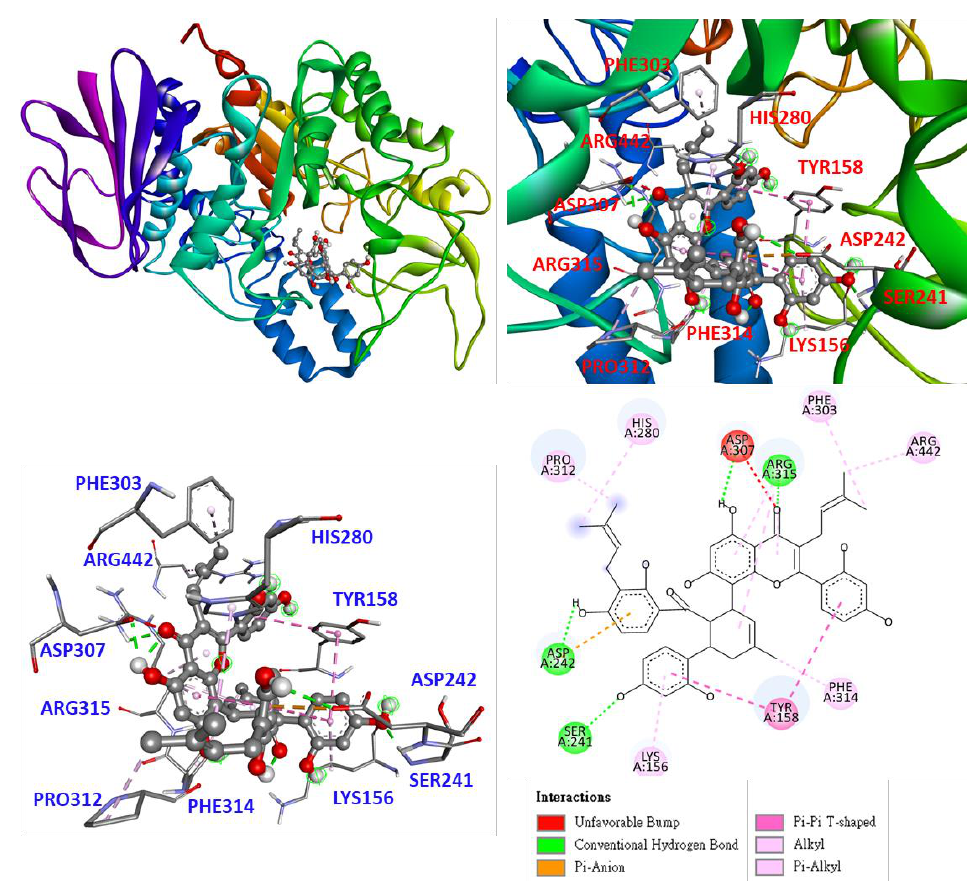
Figure 5. Interaction of acarbose with active sites of S. cerevisiae α -glucosidase.